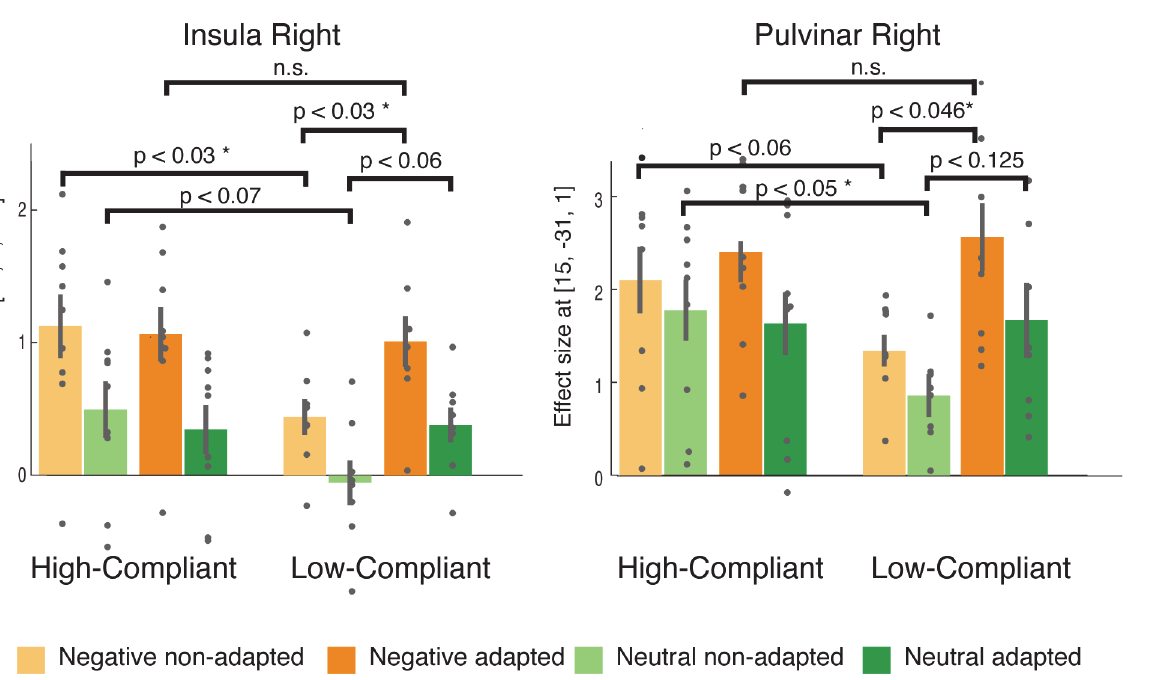
Fig 8. Exemplarily results for the increase of effect sizes due to adaption. In the ROI analysis for non-adapted vs. adapted picture presentations based on regions involved in emotional processing (main effect of emotion, Fig. 6) we found enhanced brain responses for adapted trials in Low-Compliant which, due to the adaptation, met the activation levels in High-Compliant. This picture shows this exemplarily for the right pulvinar and insula, the results are summarized in Table 2.